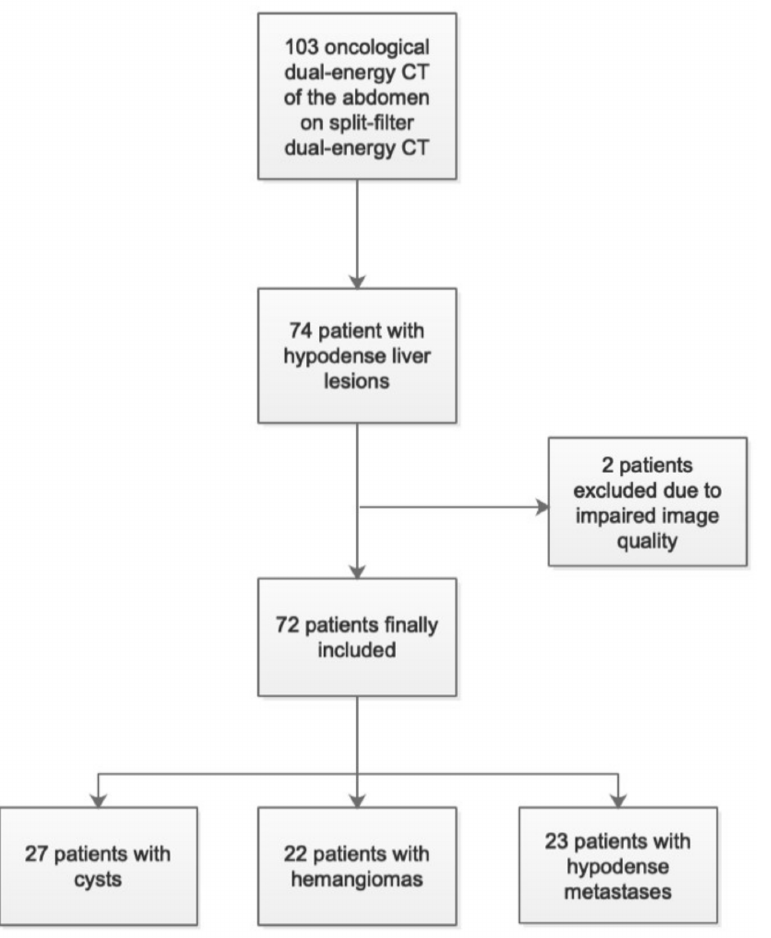
Figure 2. Patient study inclusion